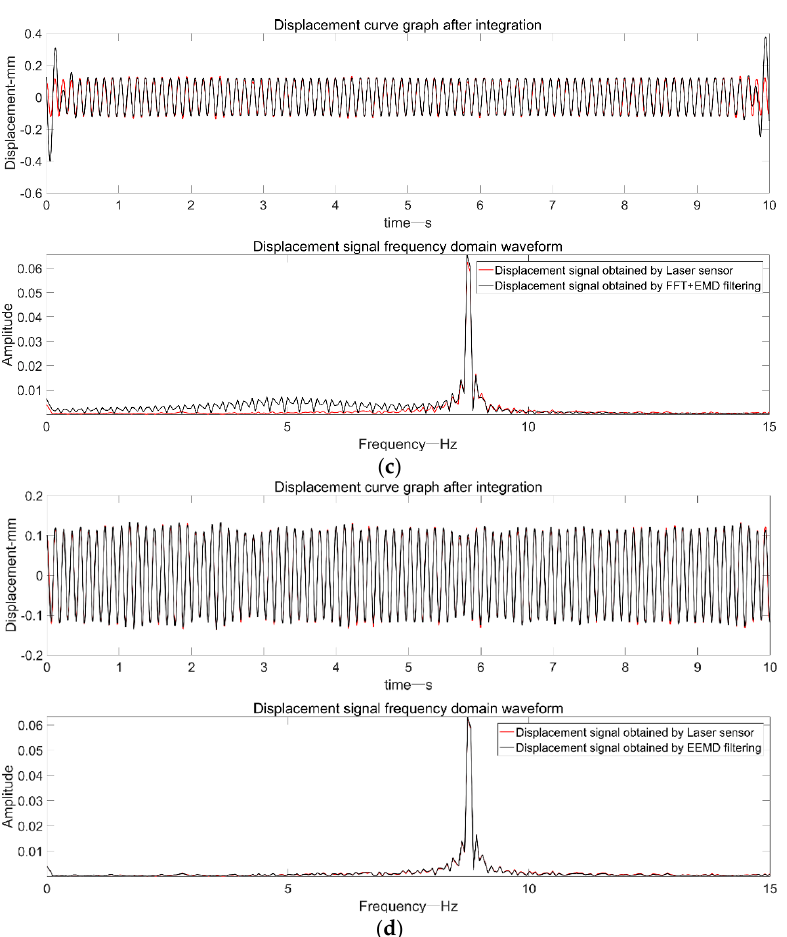
Figure 12. Four methods to realize dynamic displacement reconstruction of a shaking table: ( a ) frequency domain bandpass filtering; ( b ) EMD adaptive filtering; ( c ) FFT+EMD filtering; ( d ) EEMD adaptive filtering.